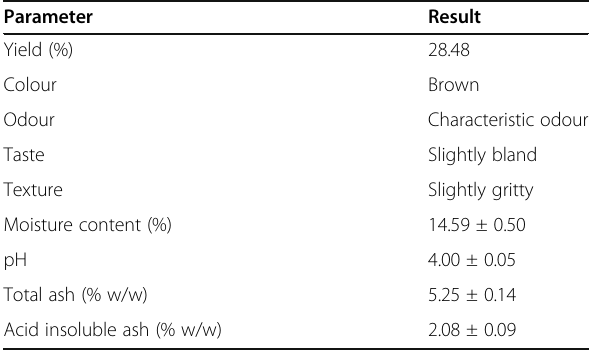
Table 1 Physicochemical and pharmacopoeial properties